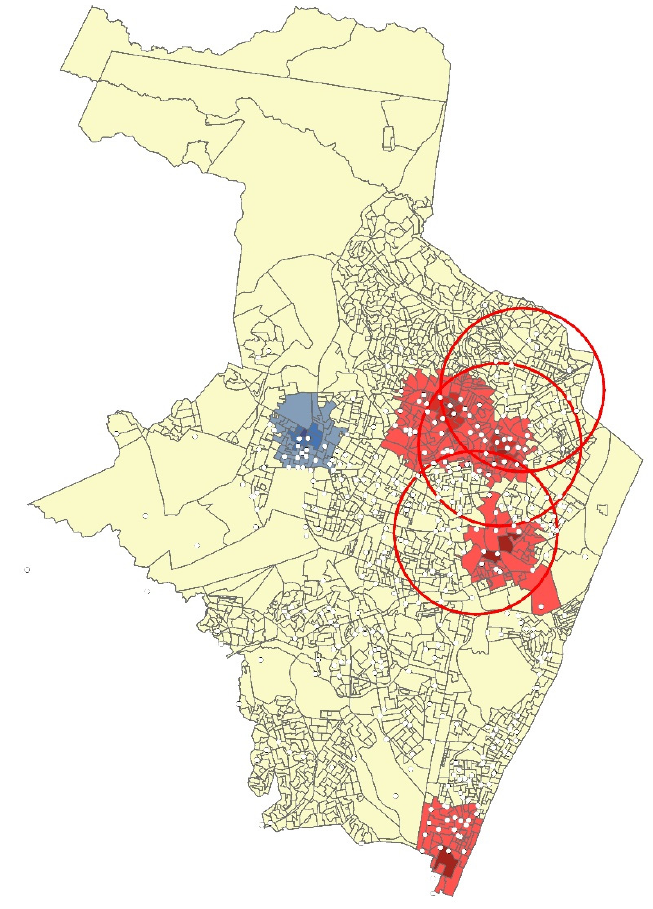
Figure 2. Distribution of incidents.